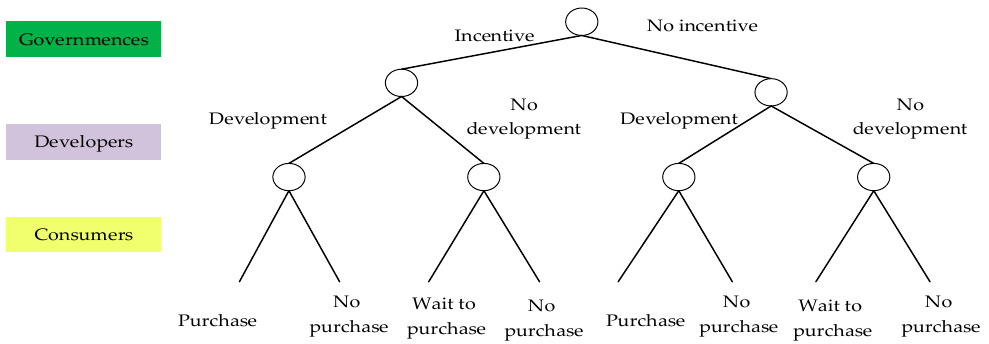
Figure 3. Game Figure 3. Game tree.